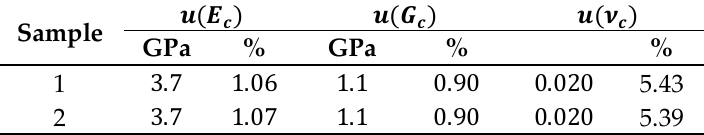
Table 4. Uncertainties on the coating elasticity constants obtained by IET.